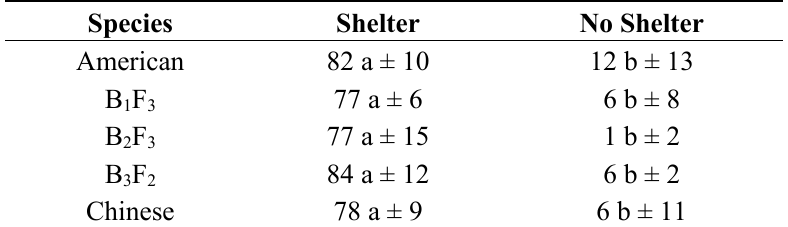
Table 1. Mean percent germination (and standard deviation) of chestnut seeds planted into mine soil in eastern Kentucky, compared within chestnut types and between sheltering treatments. Different letters indicate a significant shelter effect ( p < 0.05) within